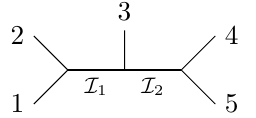
Figure 5 . A tree topology of a 5-particle amplitude. I 1 , 2 denotes two scattering channels, which together defines a partition P = {I simultaneously, which reflects the commutation relation [ W 2